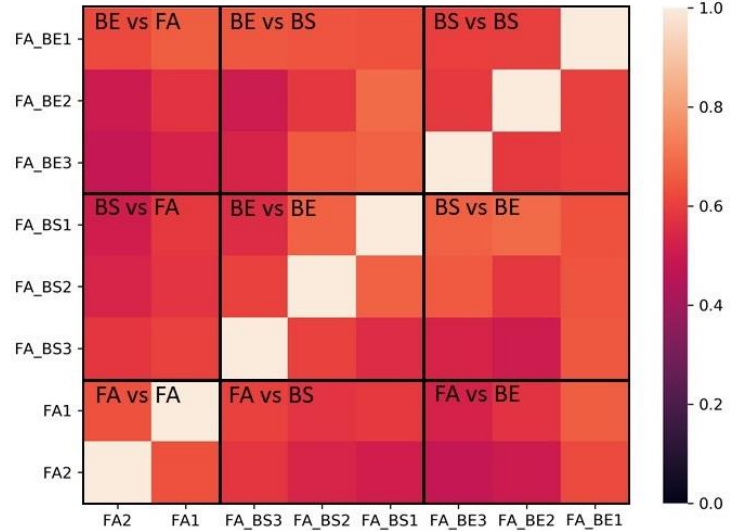
Figure 4. The heatmap from the values of J index calculated for each pair of the samples used in this study as an intersection of shared molecular formulae to the total number of formulae in the pair of samples. The color bar refers to the value of the J indices and the Cell Correlations (R 2 ). The heatmap is divided into blocks corresponding to the number of samples in each set: FA_BE (Bond Elut PPL, 3 samples), FA_BS (Bondesil PPL, 3 samples), and FA (2